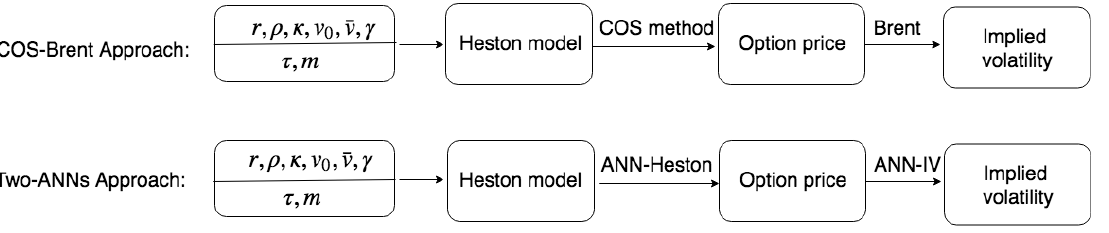
Figure 10. Two approaches of computing implied volatility for Heston model.